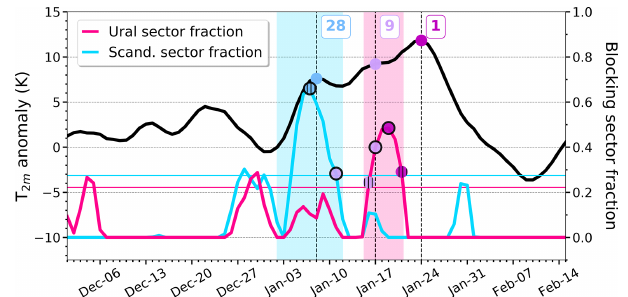
Figure 2. Daily variation of high-Arctic area-averaged T2m anoma- lies (black) and blocking fraction (based on the area fraction of the sector that intersects with a block as identified by the algorithm described in Sect. 2) area averaged over the Ural (magenta) and Scandinavian (cyan) sectors during 1 December–15 February 2006. Three Arctic warm events are marked with vertical black dashed lines with event ID indicated in boxes to the right of each event line. The magenta and cyan horizontal thin lines mark the 90th per- centile thresholds of the daily blocking fractions, and the lifetime of two blocks is indicated by magenta and cyan shading for Ural and Scandinavian blocks, respectively. The timings of the maximum blocking fraction within 3 (corresponding to the time of trajectory initialization) and 6d prior to each event are shown by hatched and solid circles, respectively, where light-blue circles refer to event 28, light-purple markers to event 9 and magenta markers to event 1. The x ticks are shown at